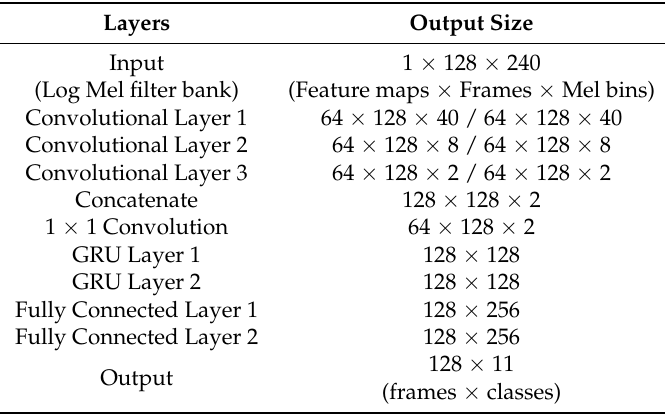
Table 2. Configuration of